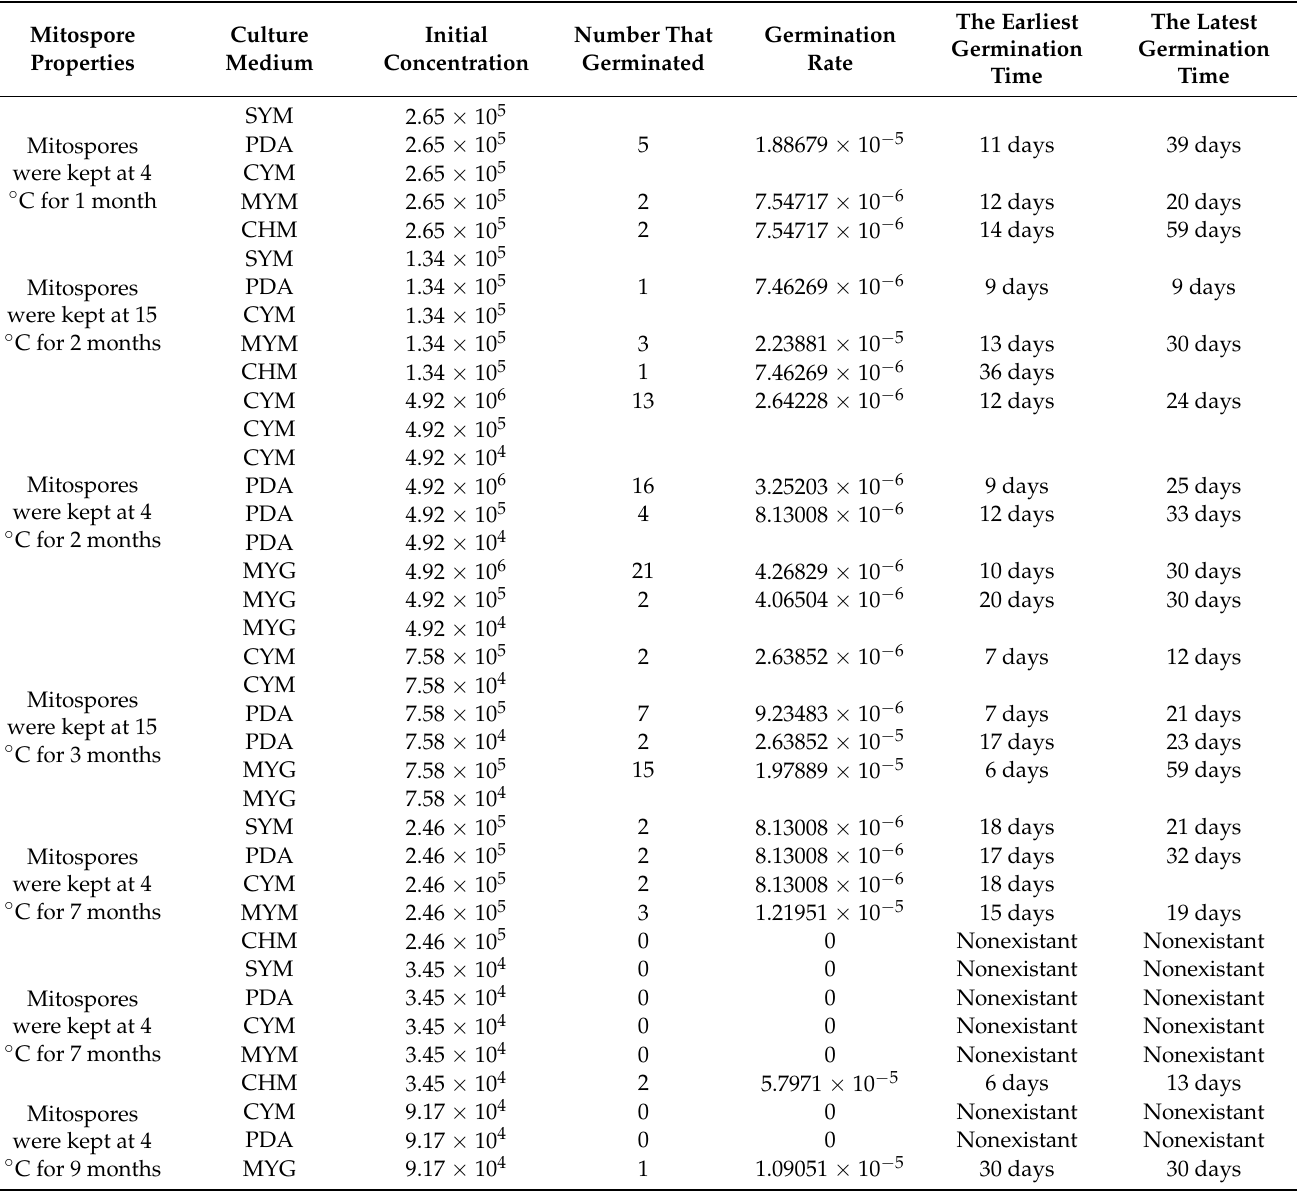
Table 1. Germination condition and state of mitospores of Morchella sextelata